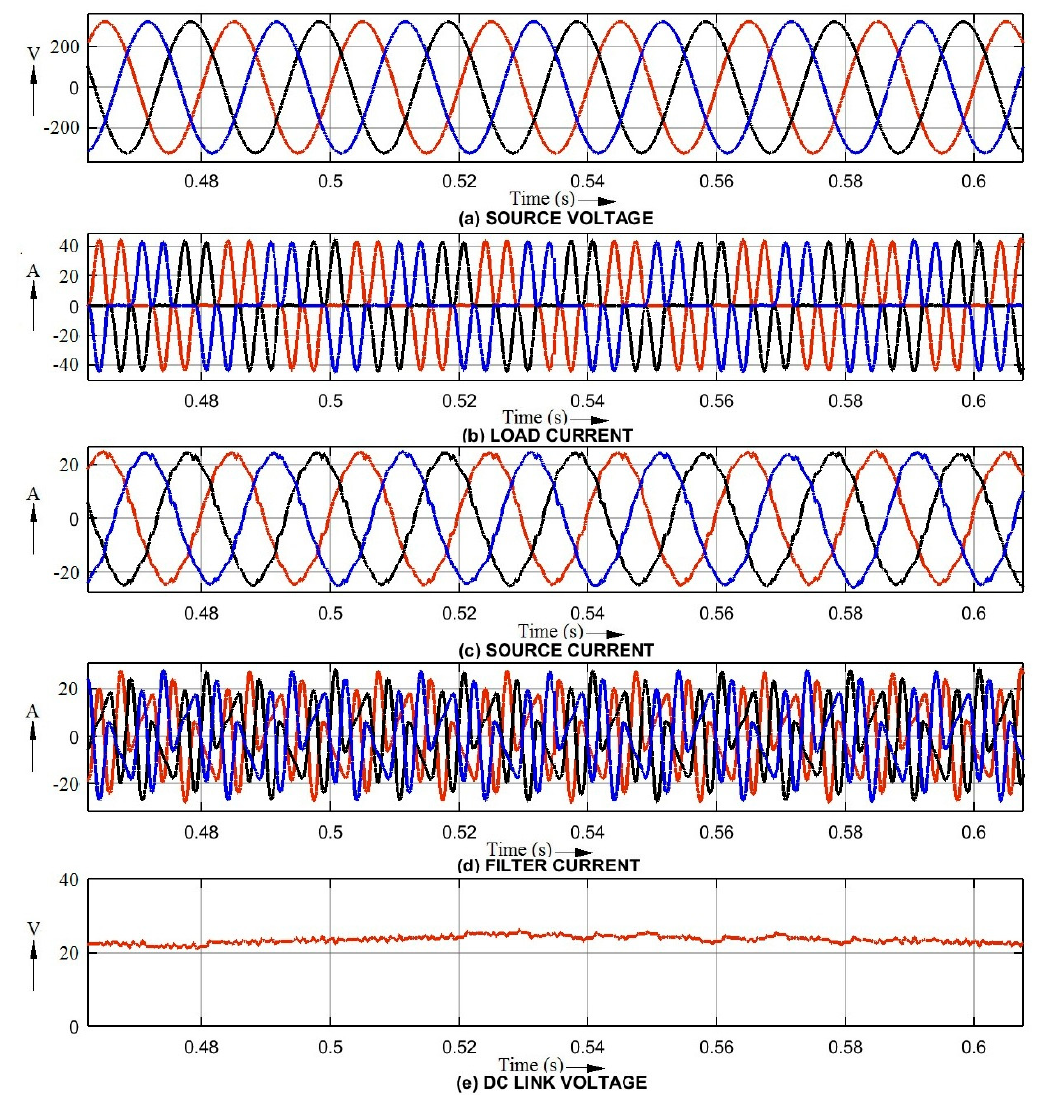
Figure 7. Performance of compensator for voltage source type nonlinear load.